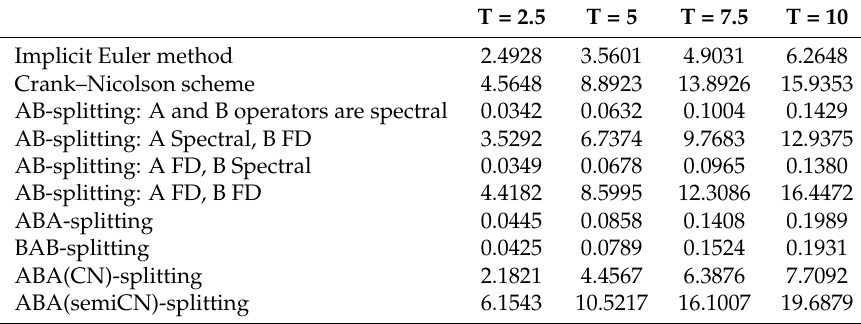
Table 5. Computational times of two solitons with the different methods.